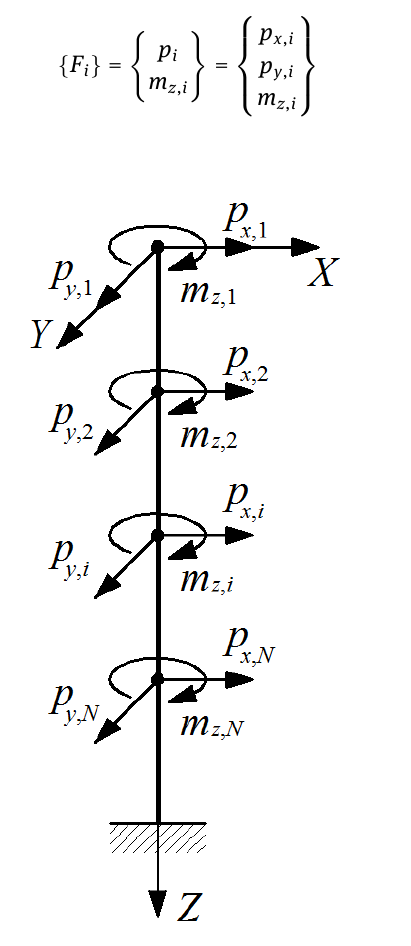
Figure 1: Scheme of a tall building in a right-handed coordinate